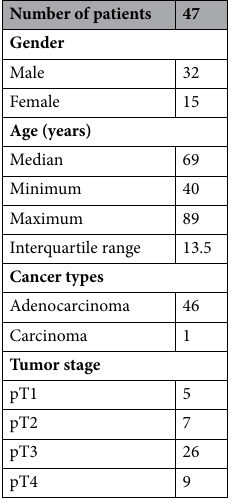
Table 1. Patient demographics and tumor